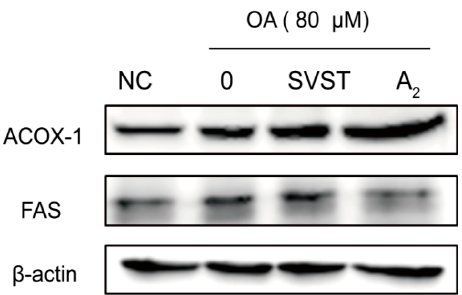
Figure 4. The relative expression of proteins related to fatty acid metabolism. NC, blank control without oleic acid; 0, model group with 80 μ M oleic acid; SVST, group with 80 μ M oleic acid and 10 μ M simvastain; A 2 , group with 80 μ M oleic acid and 10 μ M oleiferasapoin A 2 ; ACOX-1, fatty acid oxidation protein; FAS, fatty acid synthesis protein; β -actin, reference protein.